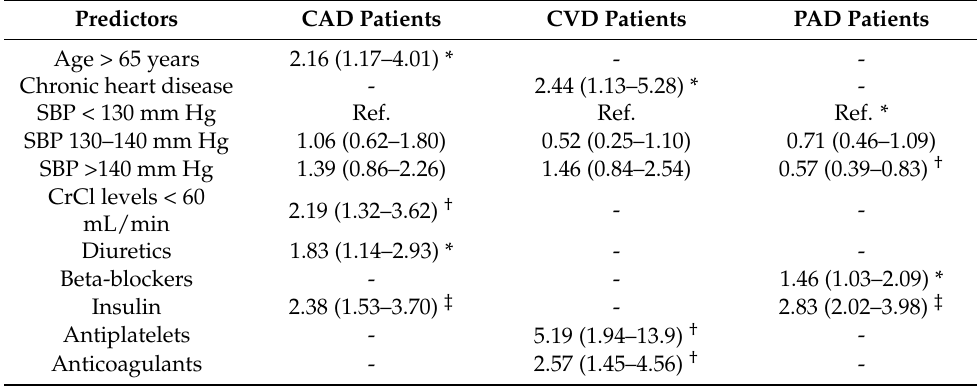
Table 3. Predictors of subsequent ischemic events. Multivariable